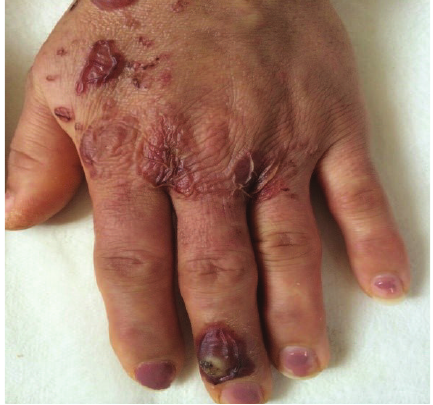
Figure 7: Target-shaped lesions after 3 days.